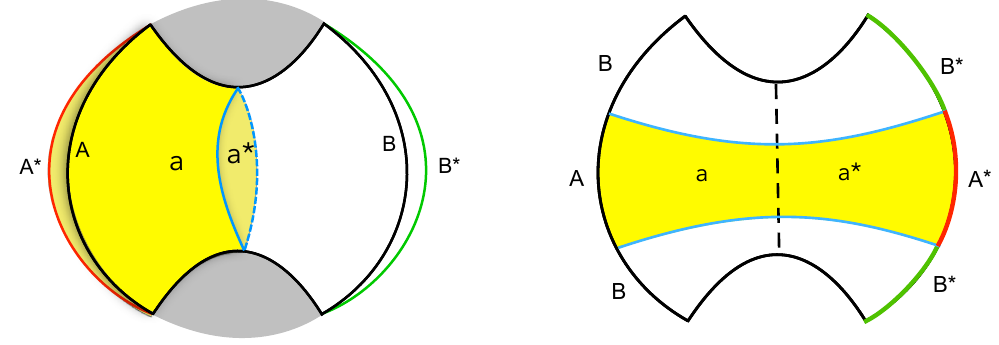
Figure 6 . The entanglement wedge r ( AA ? ) = aa ? (shown in yellow), for the cases ∂A ∩ ∂B = 0 ( left ) and ∂A ∩ ∂B 6 = 0 ( right ). The quantum correction S bulk ( a : b ) comes from the bulk entanglement R between this region and bb ? (shown in white), across the reflected minimal surfaces